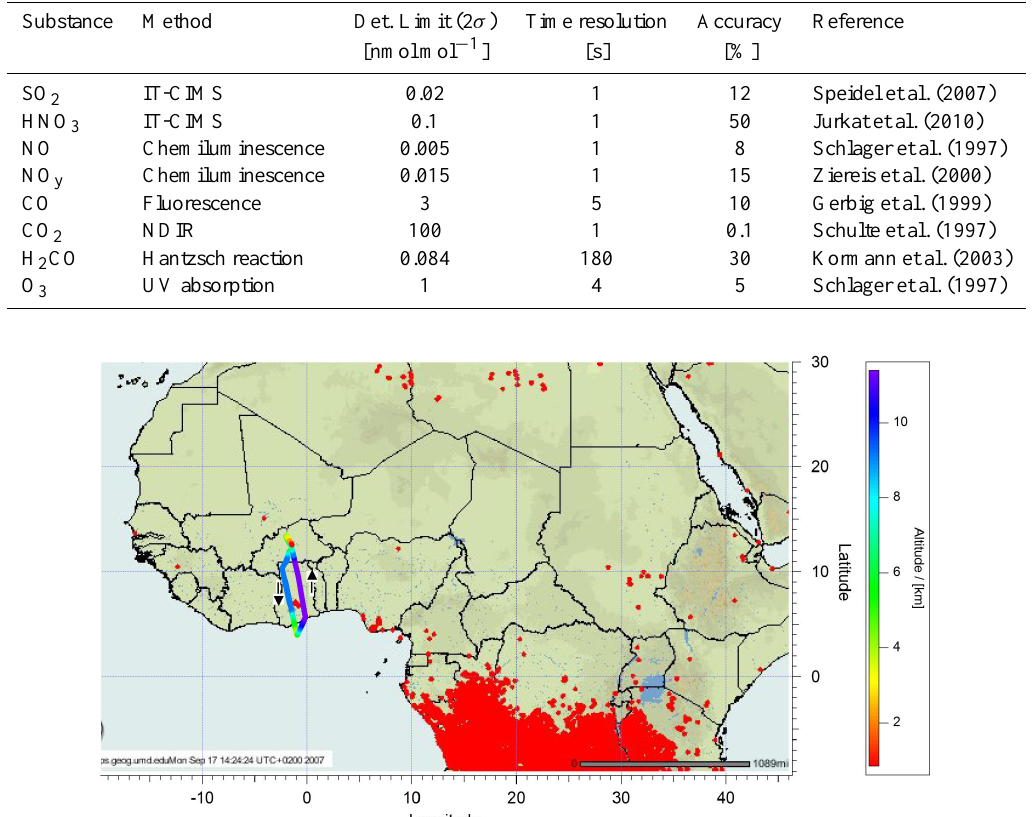
Fig. 1 is the Falcon flight path with the flight altitude